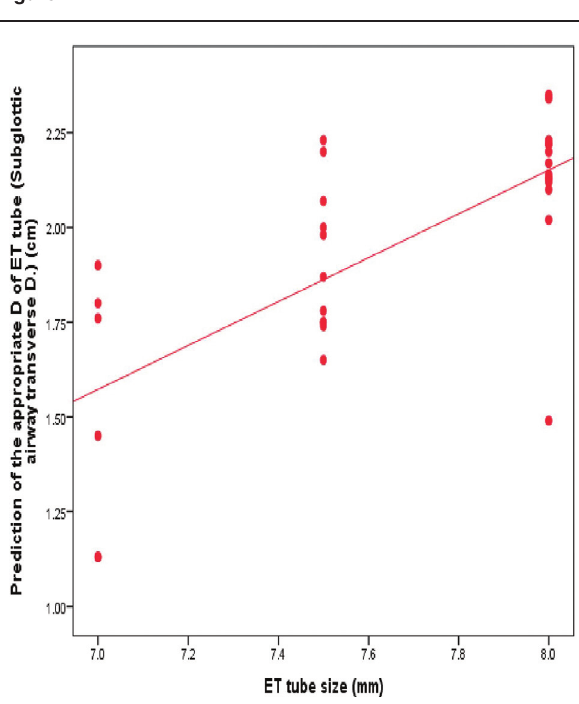
Scattered plot for subglottic airway transverse